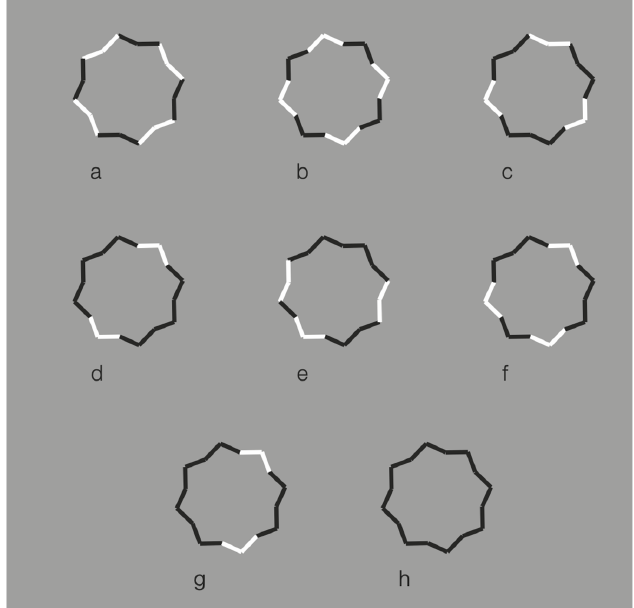
Figure 15. Further examples of the role played by contrast polarity in breaking the unitariness of a star.